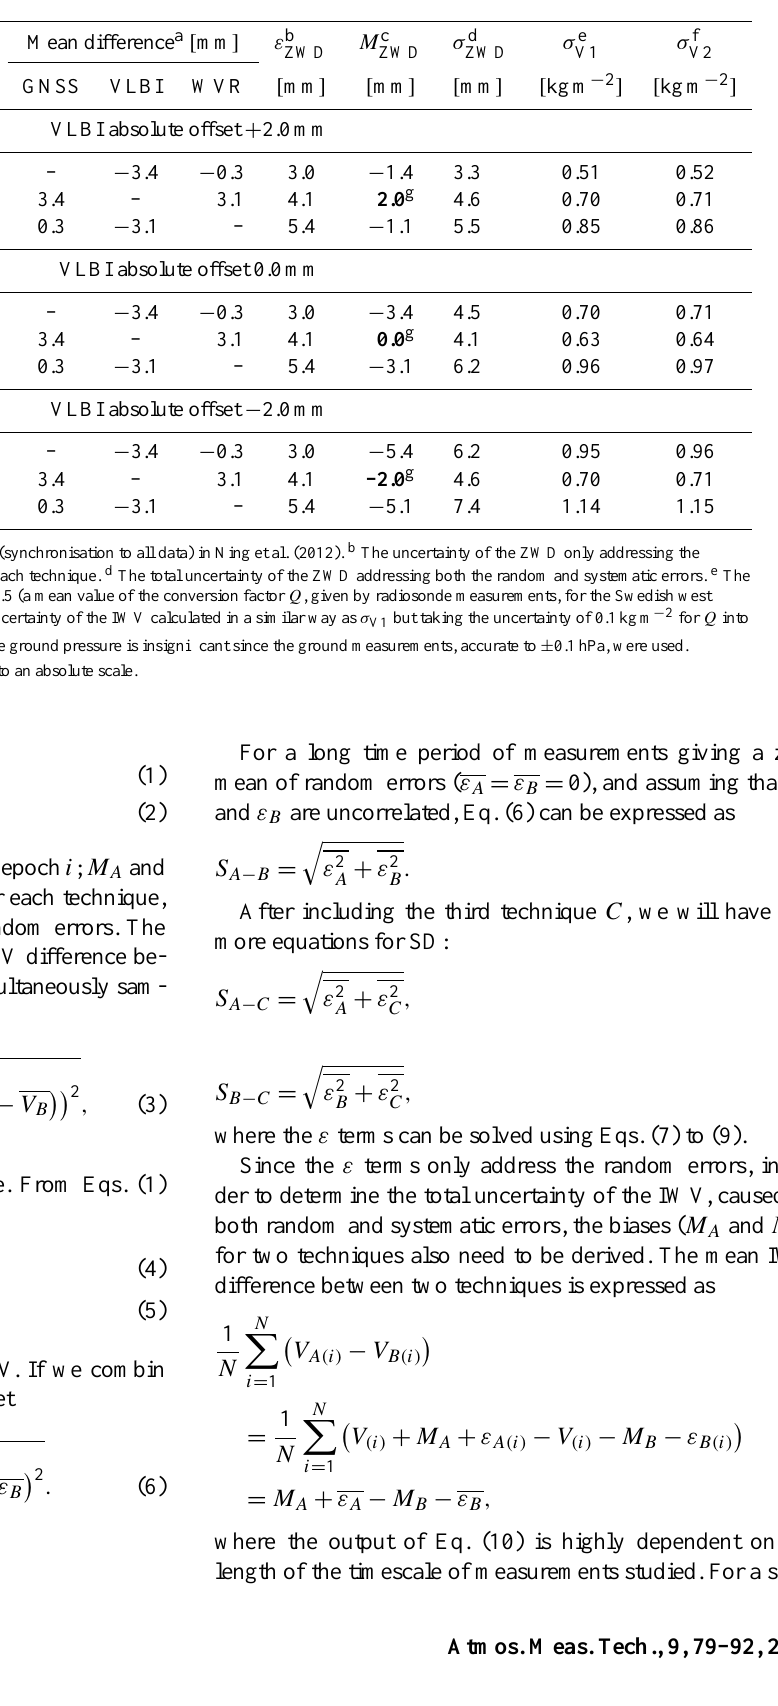
Table 1. ZWD and corresponding IWV uncertainties given by a statistical analysis using observations from Onsala on the Swedish west